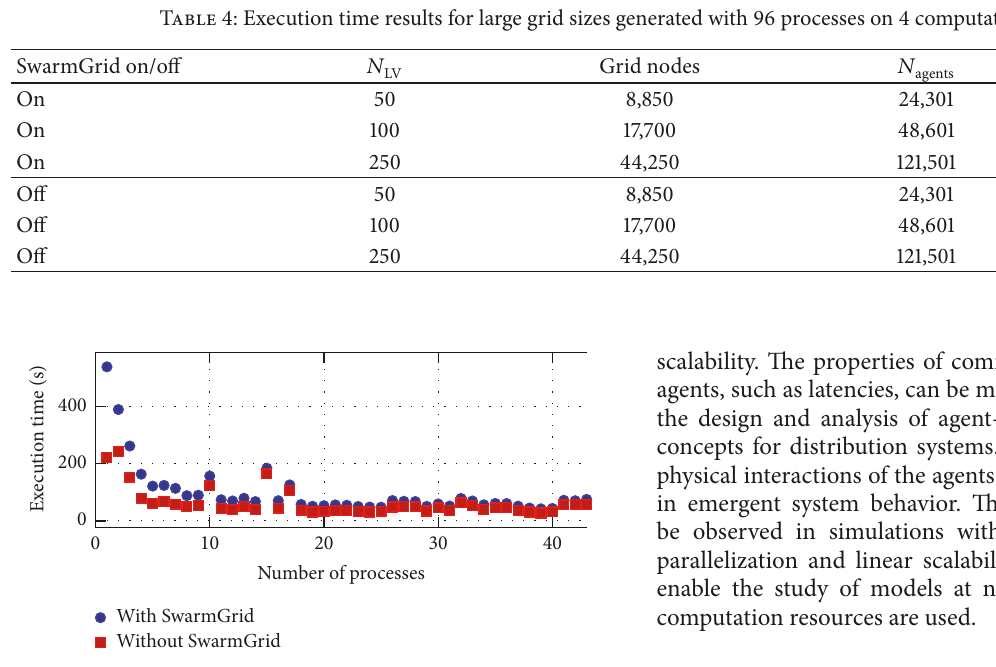
are necessary to exploit computation resources even more